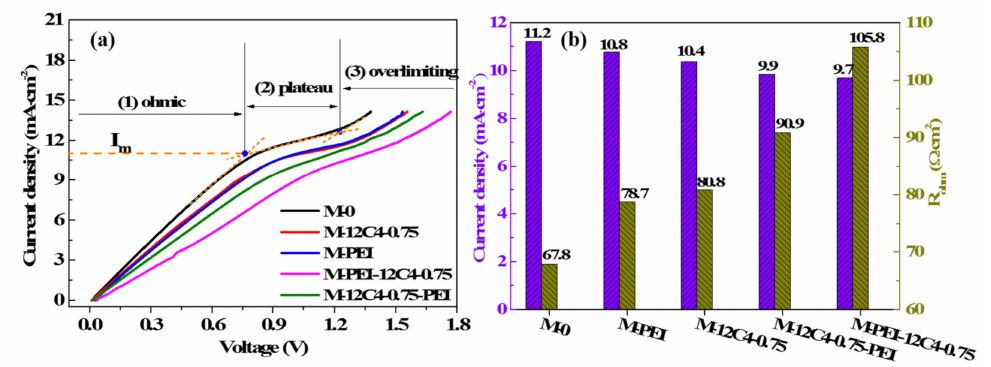
Figure 8. Current density–voltage curves ( a ) and systematic ohmic resistances ( b ) for the pristine (M-0) and modified membranes (M-12C4-0.75, M-PEI, M-PEI-12C4-0.75 and M-12C4-0.75-PEI) in 0.05 M binary mixture of LiCl and MgCl 2